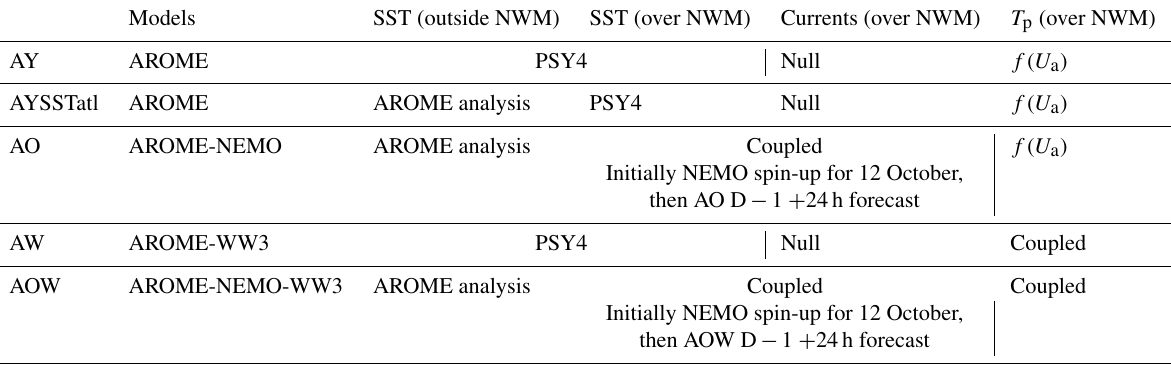
Table 2. Summary of the simulations. Outside the northwestern Mediterranean (NWM) area, surface current is always null and T p is a function of the wind ( U a ) only.